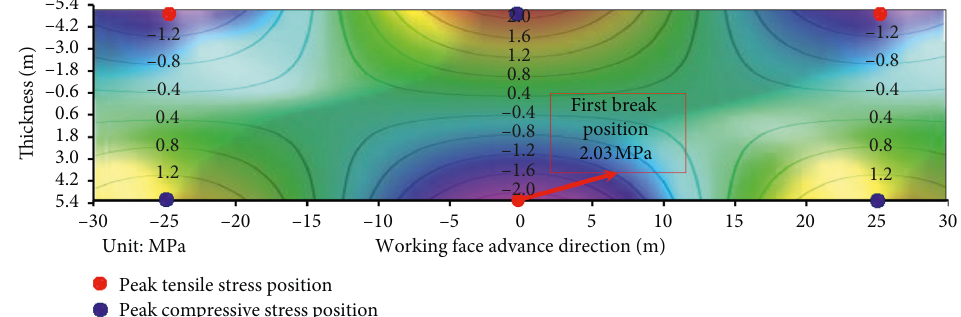
Figure 18: Contour plot of the orthogonal stress distribution of the main roof rock